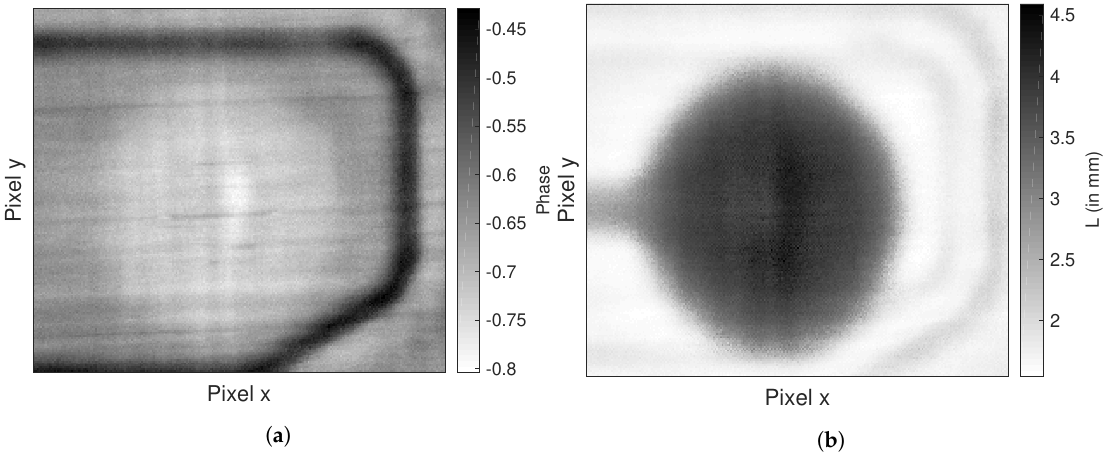
Figure 8. Resultant images of standard evaluation methods of PT: ( a ) PPT and ( b )